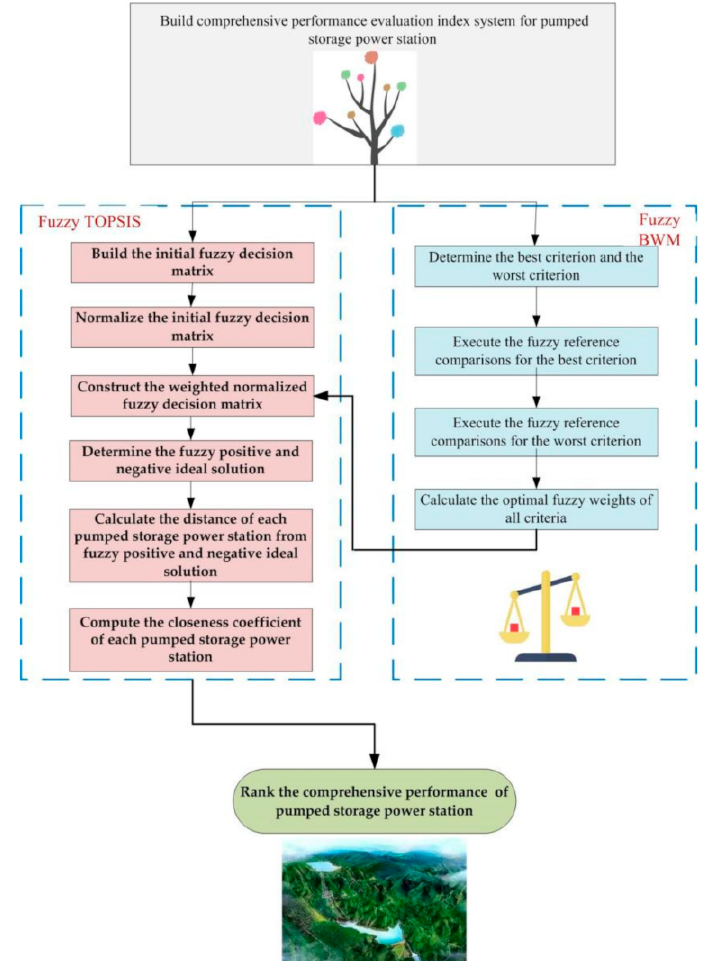
Figure 3. The procedure of the hybrid novel fuzzy MCDM method for comprehensive performance evaluation of pumped storage power